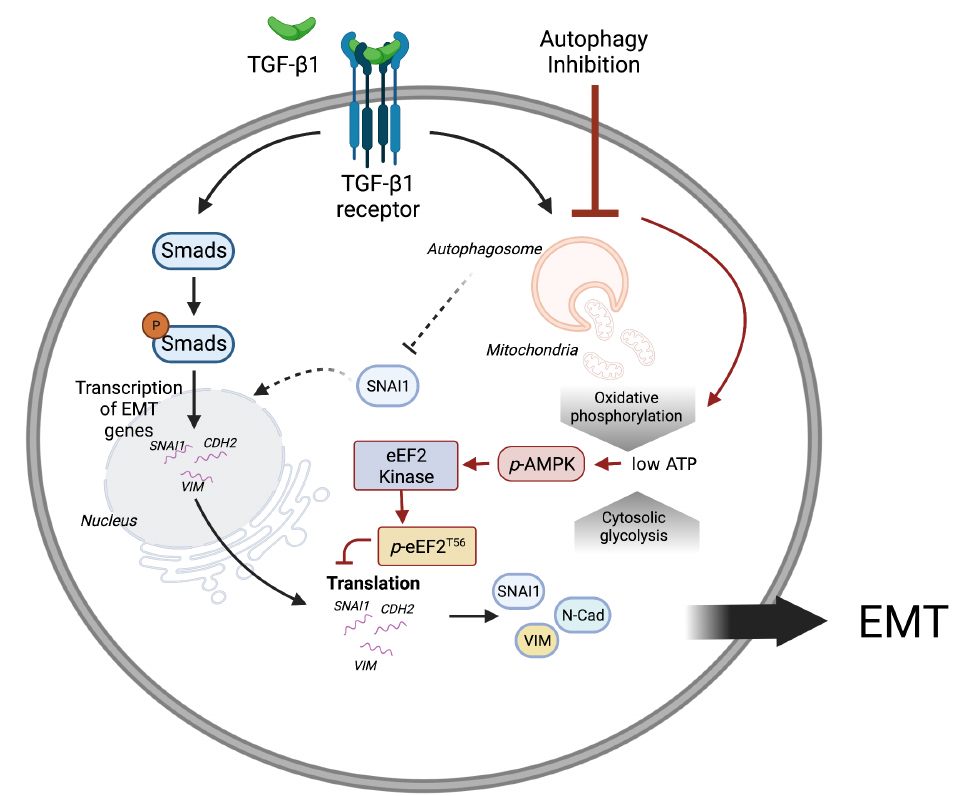
Figure 7. A schematic representation of mitochondrial homeostasis and energy balance by autophagy during TGF- β 1-induced EMT. TGF- β 1 induces the transcription of EMT proteins through the Smad transcription factors. In addition, TGF- β 1 induces autophagy which maintains mitochondrial home- ostasis and energy production. Inhibiting autophagy reduces ATP production from oxidative phos- phorylation, which consequently suppresses EMT protein translation through AMPK activation. This figure was created with